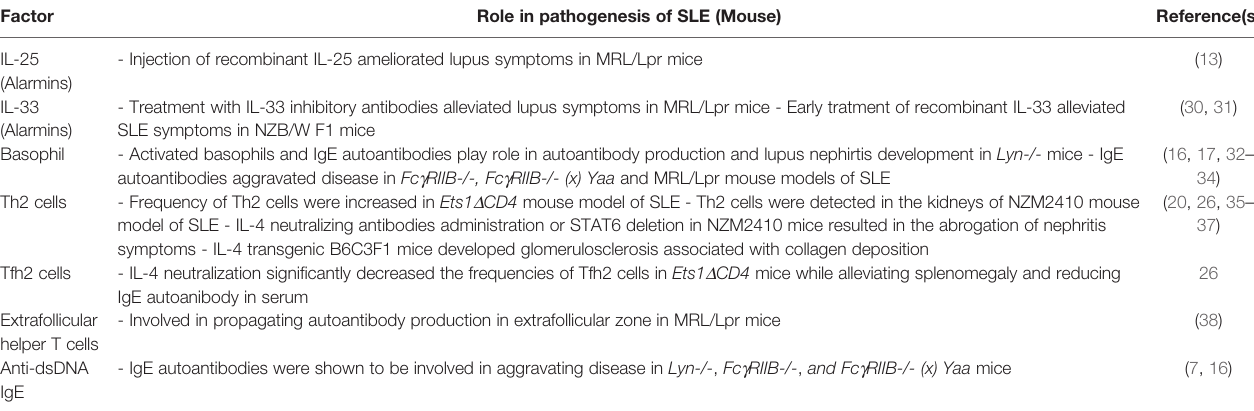
TABLE 2 | Type 2-associated immune response in SLE mouse